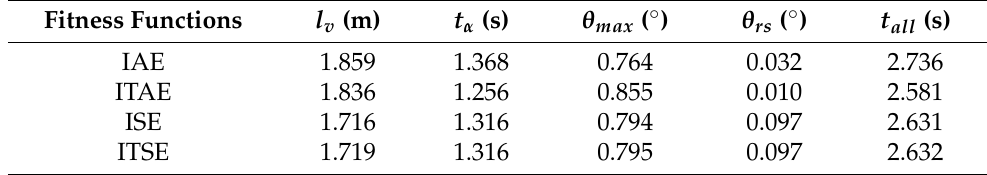
Table 2. Comparison results of different fitness